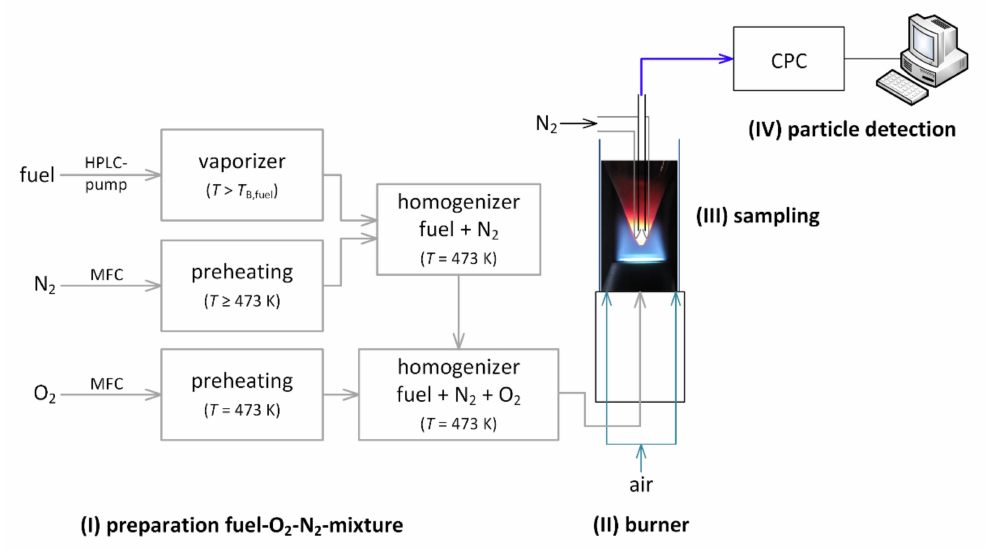
Figure 2. Scheme of the experimental set-up for the measurement of particle concentration in the exhaust gas of a plane-laminar flame. The specific preheating temperature of nitrogen is at least 473 K, subjected to the final boiling of the fuel mixture; CPC—condensation particle counter, HPLC—high performance liquid chromatography, MFC—mass flow controller, T B,fuel —final boiling point of the fuel